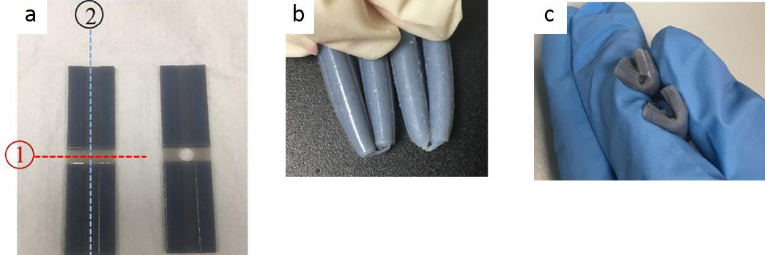
Figure 21. Crossfolding for the 0.3 mm sample for ( a ) Printed specimens with and without a hole; ( b ) Method 1—Folding line 2, followed by folding line 1; ( c ) Method 2—Folding line 1, followed by folding line 2.